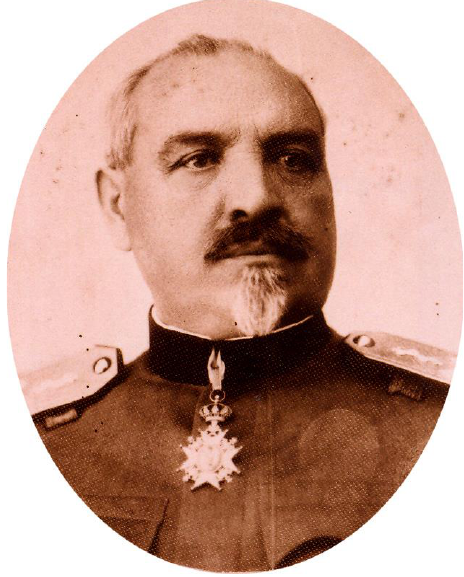
Figure 2. Dr Adolph Hempt (by courtesy of Mrs Dagmar Hempt-Miri ć (1913 – 2013), the daughter of Dr Adolph Hempt).